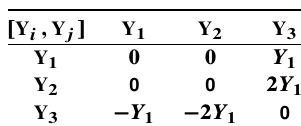
Table 2. The commutator table of g MBBM